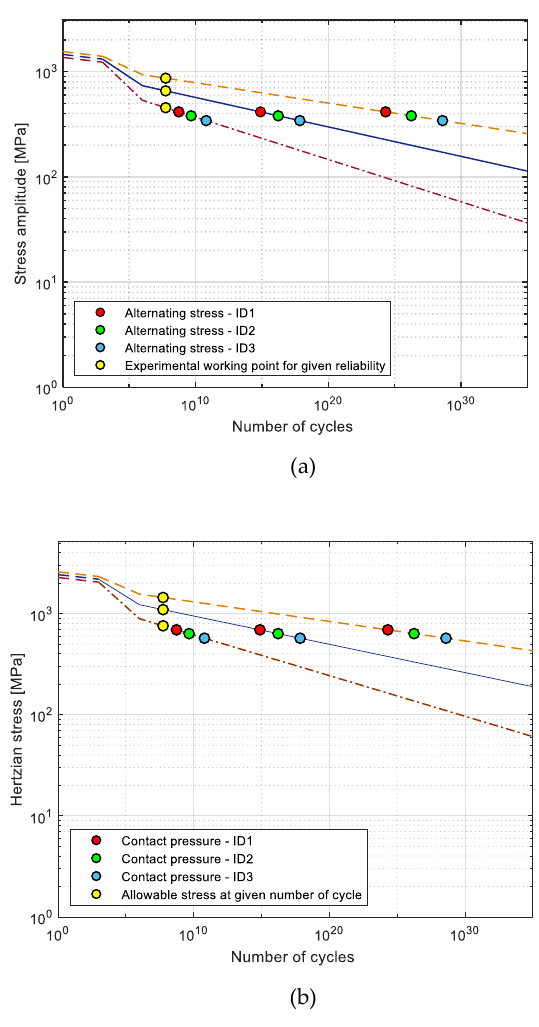
Figure 15. Comparisons between the working point obtained by the hybrid approach and the real ones: ( a ) the working point in terms of alternating stress and ( b ) the working points in terms of pressure.